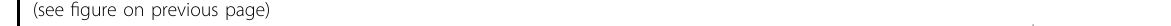
Fig. 1 Lymphatic mimicry structures in primary oral squamous cell carcinoma (OSCC). a A representative fi gure of LM + lymphatic vessel-like structure. Scale bar 50 µm. A total of 57 OSCC patient primary tumour samples were stained with CK/LYVE-1 and scored as LM + or LM − based on the criteria detailed in the results and discussion section. The paraf fi n-embedded resection specimens were obtained from patients with OSCC of the mobile tongue. Patients were treated surgically at Oulu University Hospital during the period of 2009 – 2016 with no other preoperative treatment. Informed consent was obtained from all patients. The use of these samples and data enquiry were approved by the Ethics Committee of the Oulu University Hospital and by the National Supervisory Authority for Welfare and Health (VALVIRA). For the double-label immuno fl uorescence (IF) staining, deparaf fi nised sections of human ( n = 57) and mouse ( n = 18) OSCC tissues were pretreated with 10 mM Citrate buffer (pH 6) and underwent microwave antigen retrieval in a Micromed T/T Mega Microwave Processing Lab Station (Hacker Instruments & Industries). Blocking of non-speci fi c binding was performed in 10% donkey normal serum (Sigma-Aldrich) for 1 h at room temperature (RT). Slides were then incubated with an antibody solution containing 1 µg/ml polyclonal rabbit antihuman LYVE-1 antibody (HPA042953, Sigma ‐ Aldrich, St Louis, MO, USA), and 1:200 diluted monoclonal mouse antihuman pan-cytokeratin (CK; DAKO, Carpinteria, CA, USA) overnight at + 4 °C. Human lymph node tissue was utilised as a positive control for LYVE-1. For negative controls, the primary antibodies were omitted or replaced with an antibody isotype control. After washing 3x in phosphate buffered saline (PBS), slides were then incubated with: (1) donkey anti-mouse Alexa Fluor ® ‐ 568 and donkey anti-rabbit Alexa Fluor ® ‐ 488 conjugated secondary antibodies (1:200; Vector Laboratories) for 1 h at RT and washed in PBS; (2) 4',6-Diamidino ‐ 2 ‐ phenylindole (DAPI; 1:2000; Sigma-Aldrich, Germany) for 10 min at RT and washed 2 times in PBS and once in dH2O. Imaging was performed using the fully automated Leica DM6000 microscope supplied with the Leica DF365-FX camera (Leica Microsystems, Wetzlar, Germany). b A representative fi gure of LM + cluster with an insert showing that LYVE-1 immunoreactivity is detected in the tumour cell membrane and cytoplasm. Scale bar 25 µm. c The distribution of LM + and LM − in the clinical samples from randomly selected OSCC patients ( n = 57). d A representative fi gure of normal lymphatic vessels in OSCC sample mapped with different LM-relevant markers using the multiplexed immunohistochemistry (mIHC). The results revealed that normal vessels were expressing both LYVE-1 and D2-40 with a faint expression of CD44. e A representative fi gure of LM + OSCC sample mapped by the same mIHC panel. The results revealed a strong immunoexpression of CK + /LYVE-1 + /CD31 + but completely D2-40-negative in these vessel-like structures. Scale bar 50 µm. The following antibodies were included in the mIHC panel: LYVE-1 (as above); 1:100 diluted monoclonal mouse antihuman D2-40 (Dako, Carpinteria, CA, USA); 1:100 diluted monoclonal mouse antihuman CD44 (Cell Marque, Rocklin, CA, USA); and a mix of two CK clones: (1) 1:150